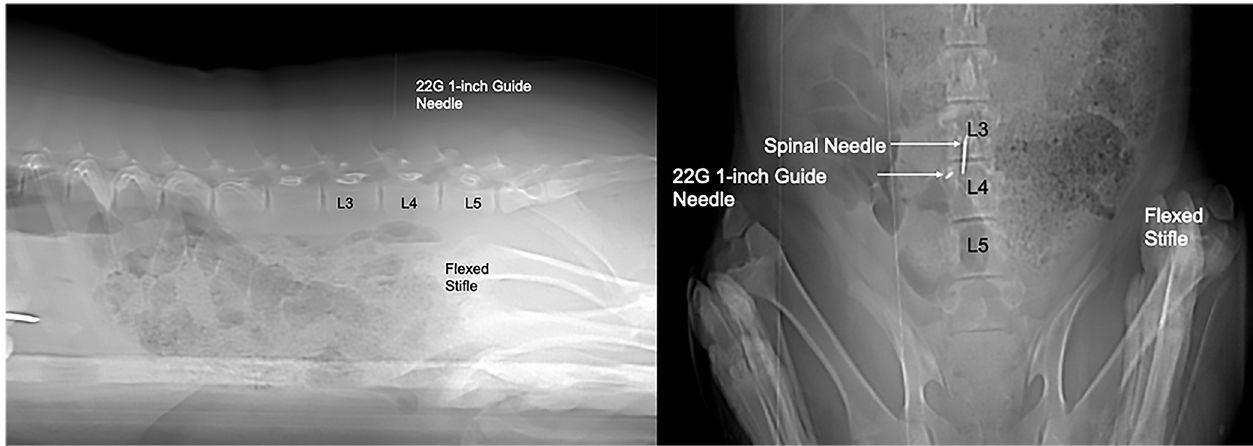
Fig 1. Sagittal and dorsal CT scout images showing guide needle and spinal needle placement. The guide needle is used to determine the site of insertion of the spinal needle on the skin. The needle is placed perpendicular to the long axis of the spine and immediately cranial to the border of the flexed stifle and directed perpendicularly. The spinal needle is placed into the vertebral canal immediately cranial to the guide needle and advanced until the tip meets the ventral surface of the spinal canal.